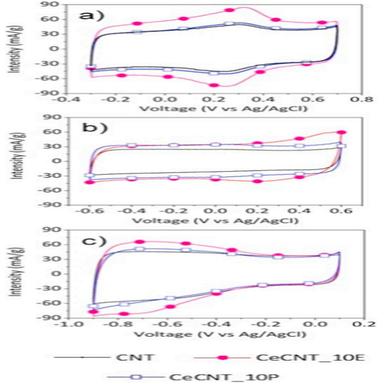
Cyclic voltammetry for CNT, CeCNT_10E and CeCNT_10P in a) 1 M H2SO4 b) 1 M Na2SO4 and c) 1 M NaOH electrolytes.